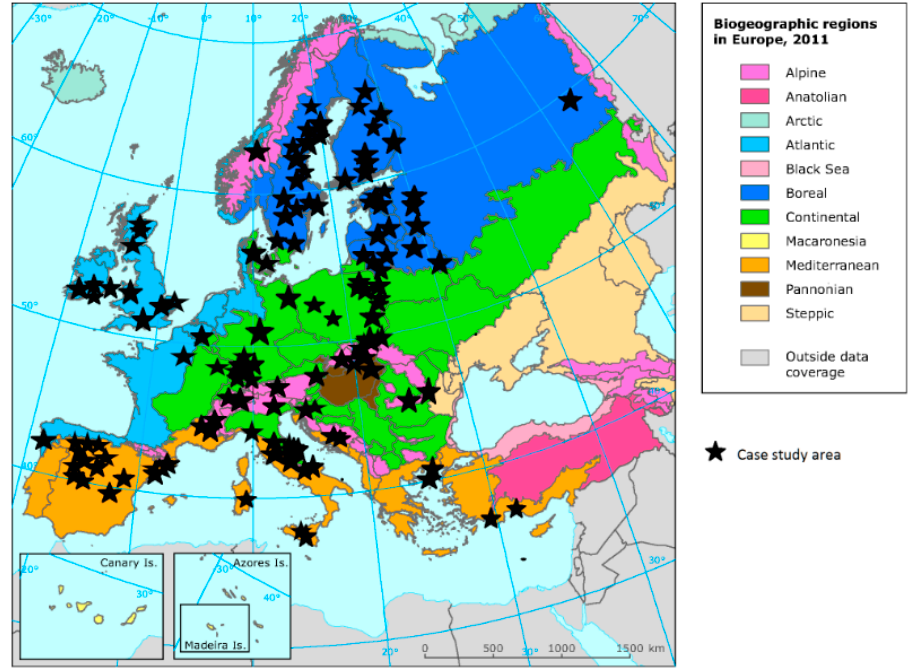
Figure 2. Distribution of case studies across biogeographic regions in Europe (note: nine studies had more than one case study